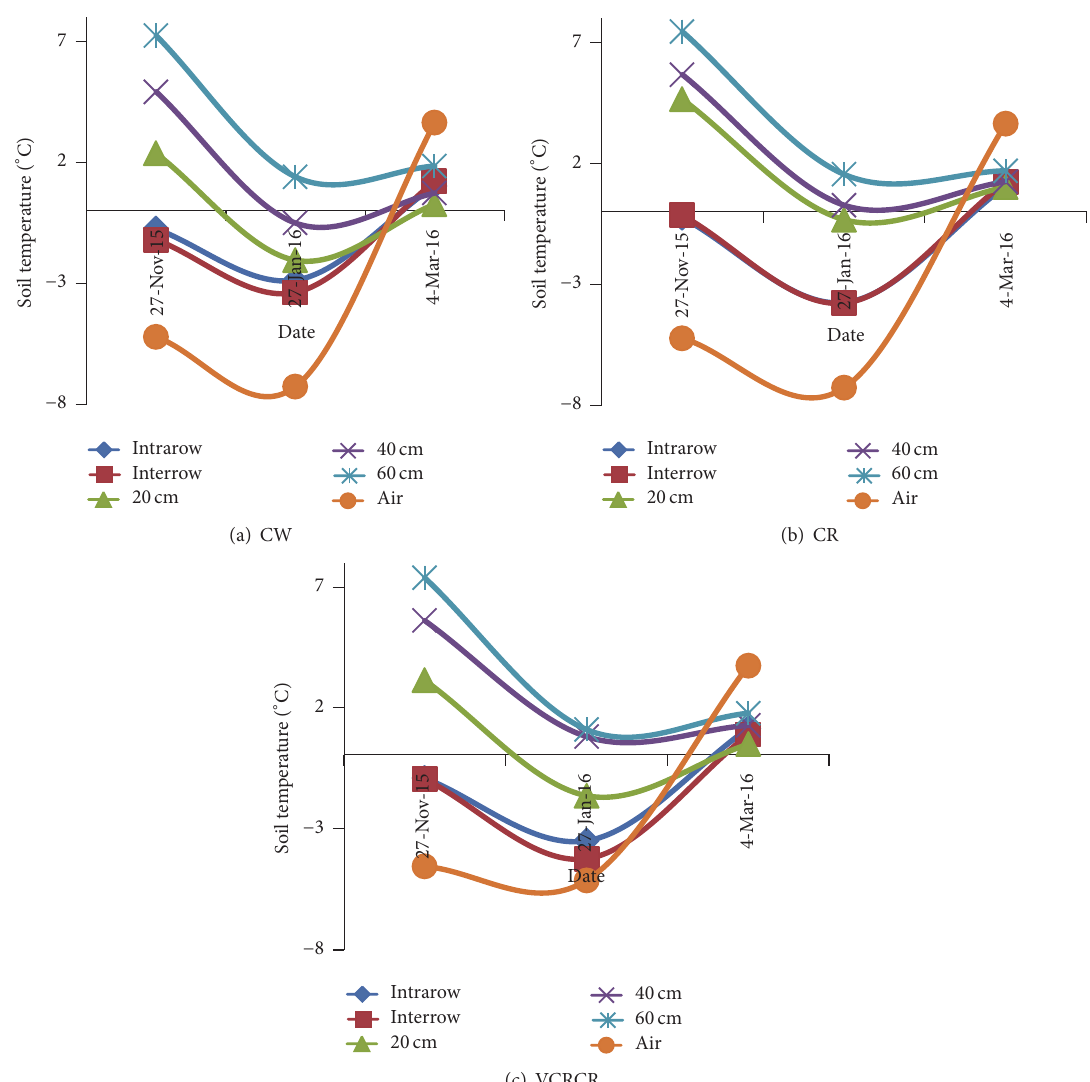
Figure 3: Mean soil and air temperature during wintering